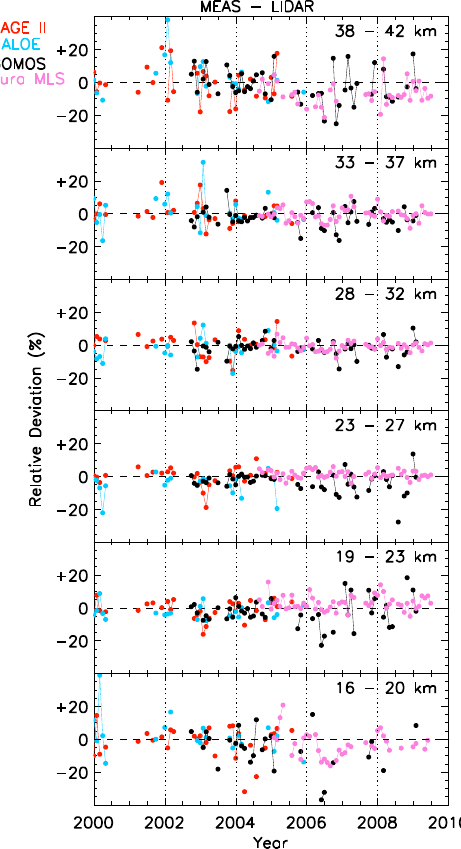
Fig. 7. Time series of the monthly average of the relative differ- ences of SAGE II, HALOE, GOMOS and Aura MLS with lidar. The dashed horizontal line represents 0% and the dotted vertical lines represent years 2002, 2004, 2006 and 2008.